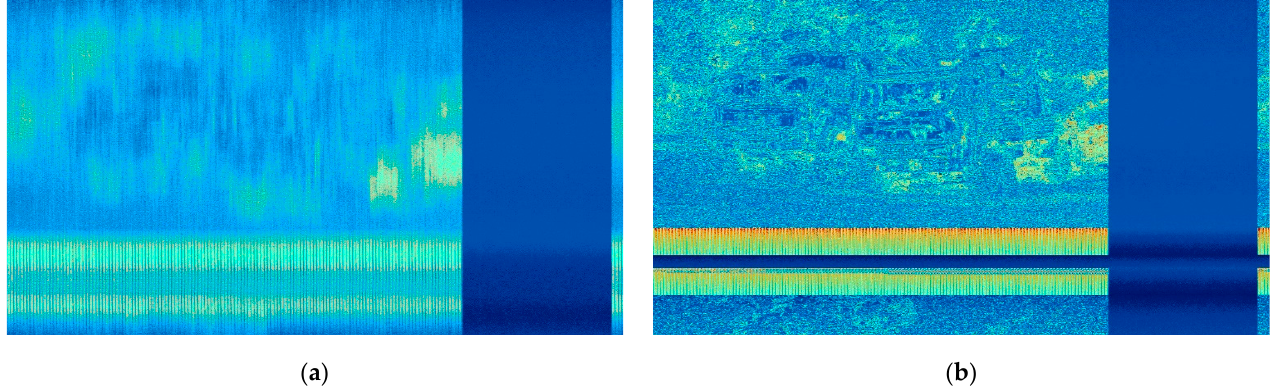
Figure 12. Images reconstructed from the revealing emission signal measured at the frequency f o = 1334 MHz for the number of lines of this image determined in accordance with the criterion of the maximum value of the measures presented in Figure 11: ( a ) the number of image lines determined in accordance with method V ( B = 1062, the number of lines smaller than required), ( b ) number of image lines determined in accordance with methods I, II, III, IV, VI, and VII ( B Corr = 1066, correct number of lines).